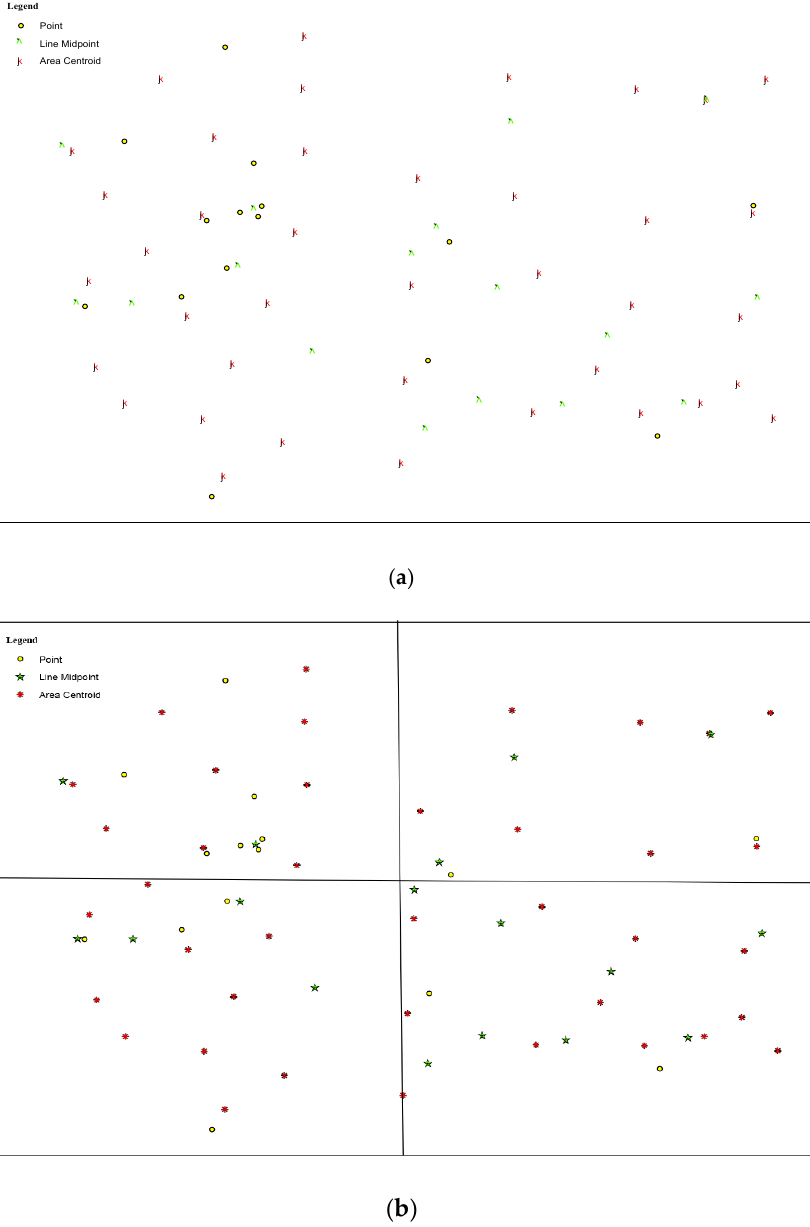
Figure 3. ( a ) The representation of multiple geographical features: area features are represented by their centroid; line features are shown by their midpoint; point features are shown as points. ( b ) Presentation of the concept of map segmentation based on the idea of regular rectangles.